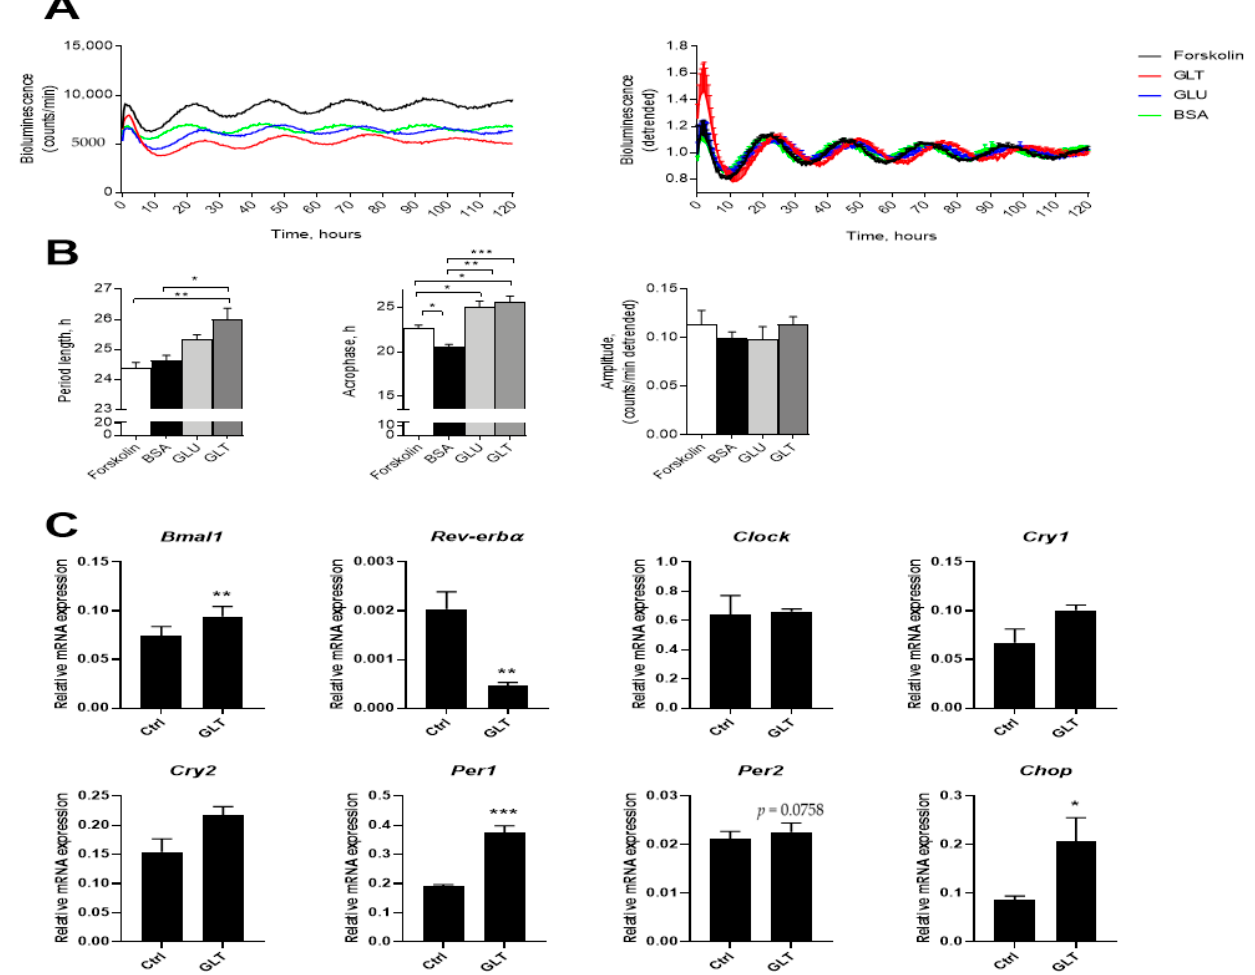
Figure 6. Glucolipotoxicity (GLT) alters clockwork in synchronized human Per2-luc reporter islets and clock gene expression in non-synchronized INS-1E cells. ( A ) Average raw (left panel) and detrended (right panel) Per2-luc oscillatory profiles recorded from forskolin-synchronized human islets ( n = 3 human donors) exposed to a combination of 500 nM palmitate and 20 mmol glucose (GLT), to 20 mmol glucose (GLU), or to BSA (bovine serum albumin; palmitate carrier) alone. ( B ) Average period length, acrophase, and amplitude were calculated based on the detrended values. See also Figure S6. ( C ) INS-1E cells were exposed to 0.5 mM palmitate + 25 mM glucose (GLT) for 12 h. Relative mRNA expression was calculated using Hprt1 as reference gene ( n = 4). Values are means or means ± SEM. Statistics are one-way ANOVA with Tukey corrected multiple comparisons ( B ) or paired Student’s t -test ( C ). Significance levels were annotated as follows: * = p -value < 0.05, ** = p -value < 0.01, *** = p -value <